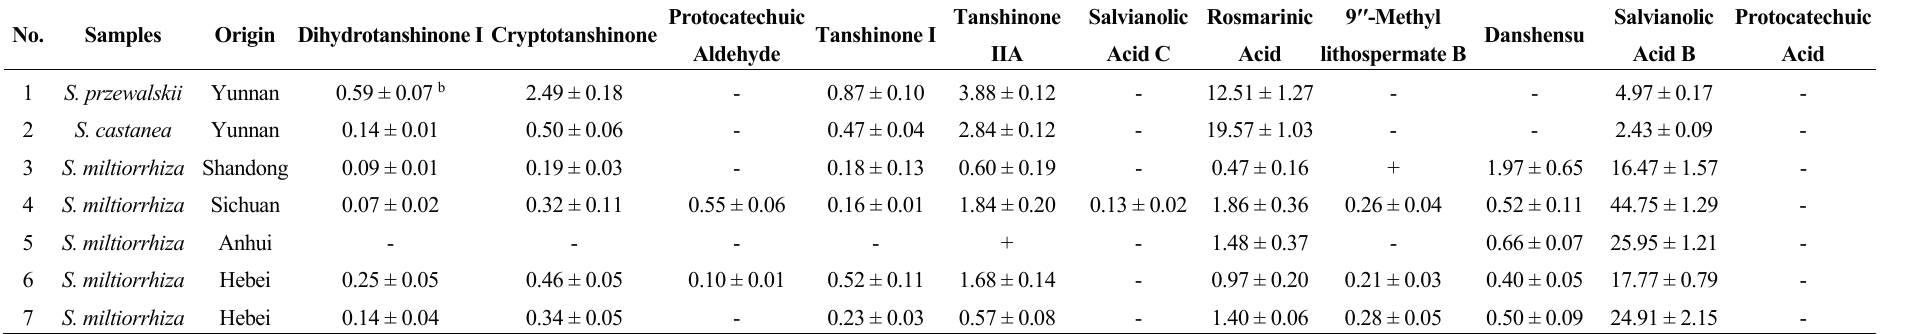
Table 3. Contents (mg·g − 1 ) of 11 compounds in samples from different origins a .